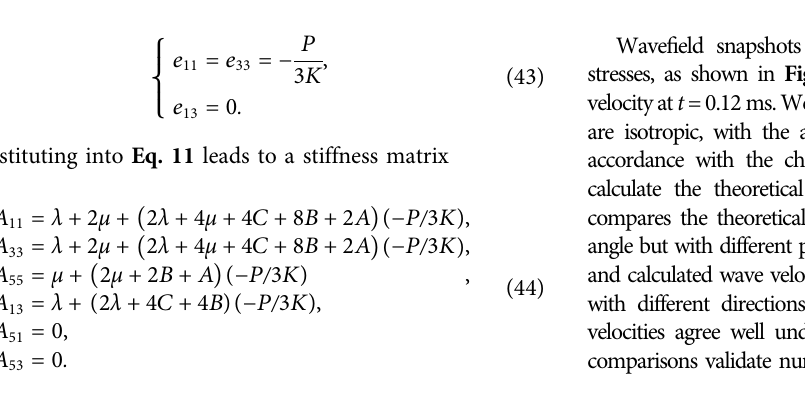
Frontiers in Earth Science |